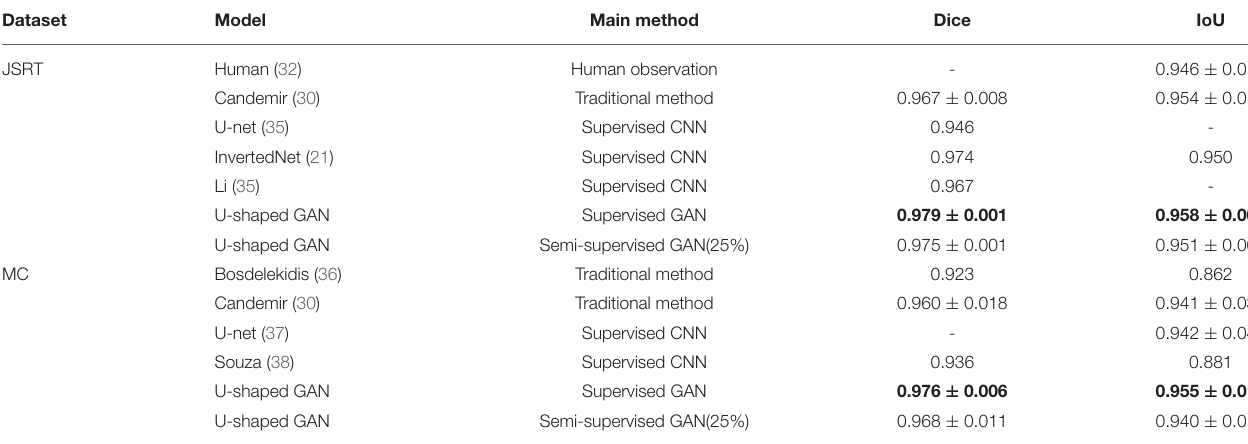
TABLE 2 | Comparison of U-shaped GAN with other lung segmentation methods for chest radiograph datasets.